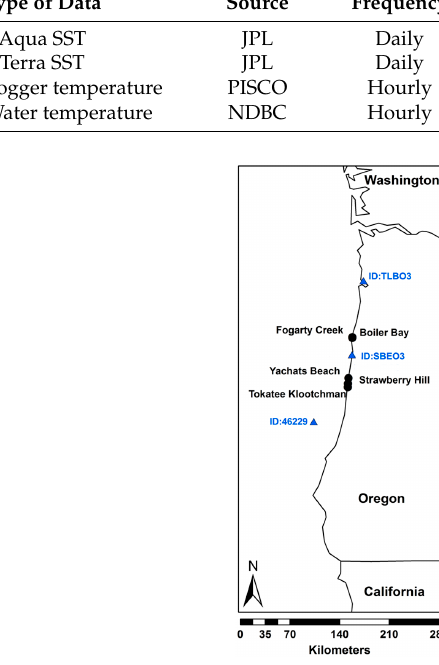
Figure 1. A map of the temperature collection locations and study sites along the Oregon coastline. Table 2. Study site name, geographical location, and number of daily observations for each study site.